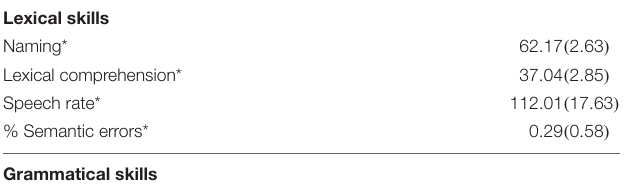
TABLE 5 | Means (and standard deviations) showing demographic data of the group of controls after the reduction to equal the number of participants in the two groups.